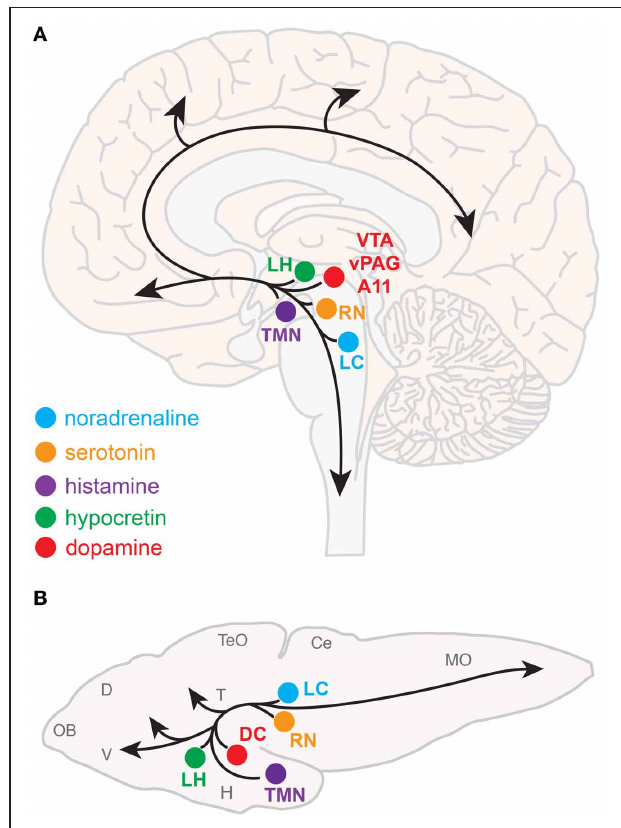
FIGURE 1 | Neuromodulatory systems that promote arousal in vertebrates. The approximate locations of key neuromodulatory regions are shown for human (A) and larval zebrafish (B) brains. Arrows indicate ascending projections that increase forebrain excitation and descending projections that increase muscle tone and sensorimotor function. Abbreviations of neuromodulatory regions: LC, locus coeruleus; RN, raphe nuclei; VTA, ventral tegmental area; vPAG, ventral periaqueductal gray; A11, mammalian dopamine cell group A11; DC, dopaminergic diencephalic cluster; TMN, tuberomammillary nucleus; LH, lateral hypothalamus. Abbreviations of larval zebrafish brain anatomy: OB, olfactory bulb; D, dorsal telencephalon; V, ventral telencephalon; TeO, optic tectum; H, hypothalamus; T, thalamus; Ce, cerebellum; MO, medulla oblongata. Note human and larval zebrafish brains are not depicted to